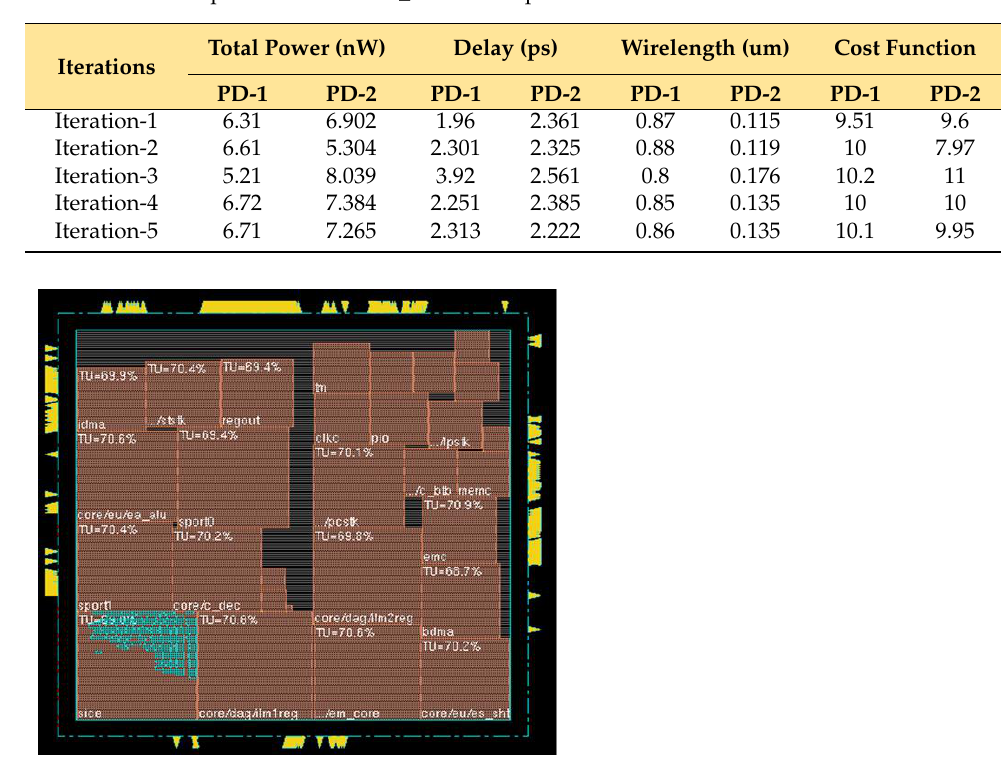
Table 4. Iterative optimization in DSP_CORE floorplan.